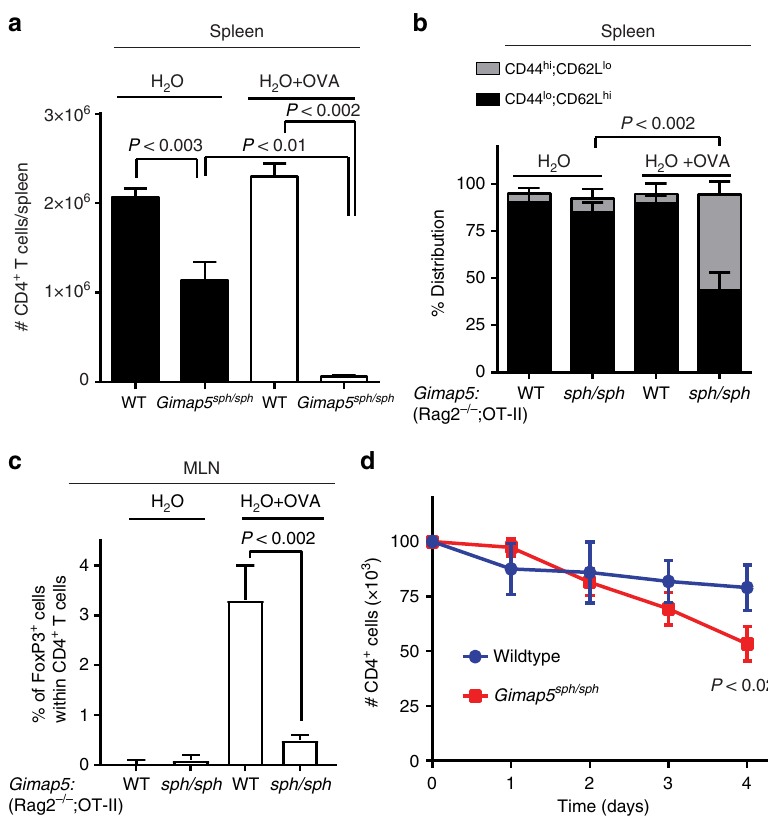
Fig. 1 Loss of Gimap5 impairs CD4 + T cell survival and iTreg cell induction. Ten-week-old control Gimap5 WT/WT ; Rag2 − / − ;OT-II and Gimap5 sph/sph ; Rag2 − / − ; OT-II mice received either normal water or water containing 1 mg/mL ovalbumin ad libitum during a 5-week period. At 15 weeks of age, a the number of splenic CD4 + T cells and b the percentage of naïve (CD44 lo ;CD62 hi ) and memory-like (CD44 hi ;CD62 lo ) CD4 + T cells was determined using fl ow cytometry. c Frequency of iTregs (CD4 + CD25 + ) in the mesenteric lymph nodes (MLN) of vehicle- and OVA-treated mice ( n = 4). d Survival of peripheral (splenic) CD4 + T cells ex vivo in the presence of IL-7 (5 ng/mL) as determined by live/dead staining and fl ow cytometry ( n = 3). Data represent mean values + SD of samples from individual mice; statistical signi fi cance is determined by Student ’ s two-tailed